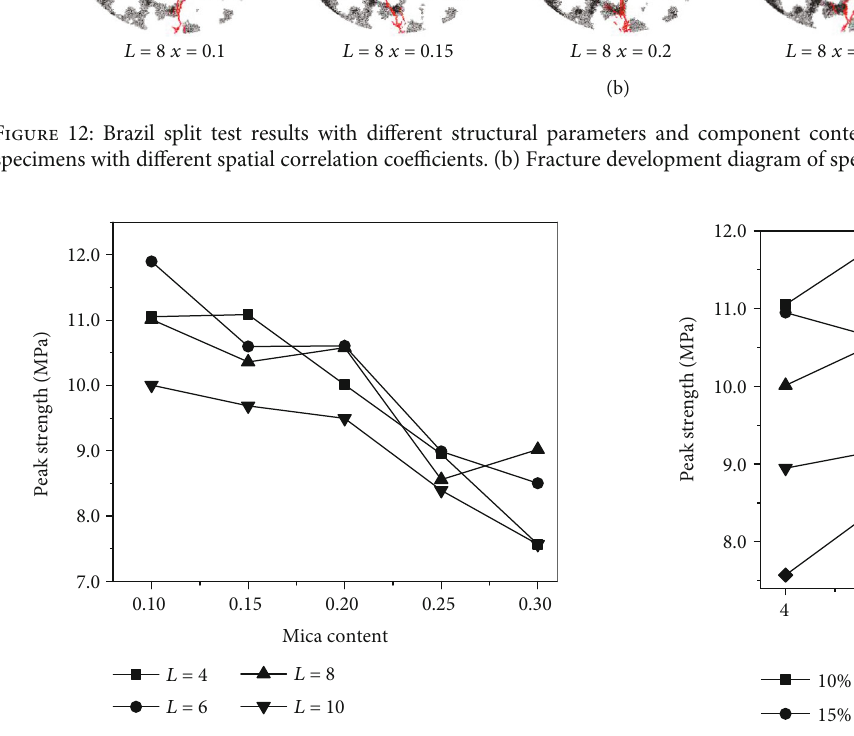
Figure 13: The relationship between the peak strength and the content of mica. Figure